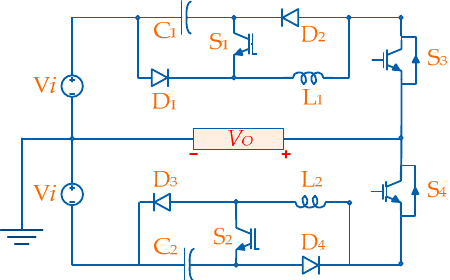
Figure 8. Half-bridge quasi-switched boost inverter.